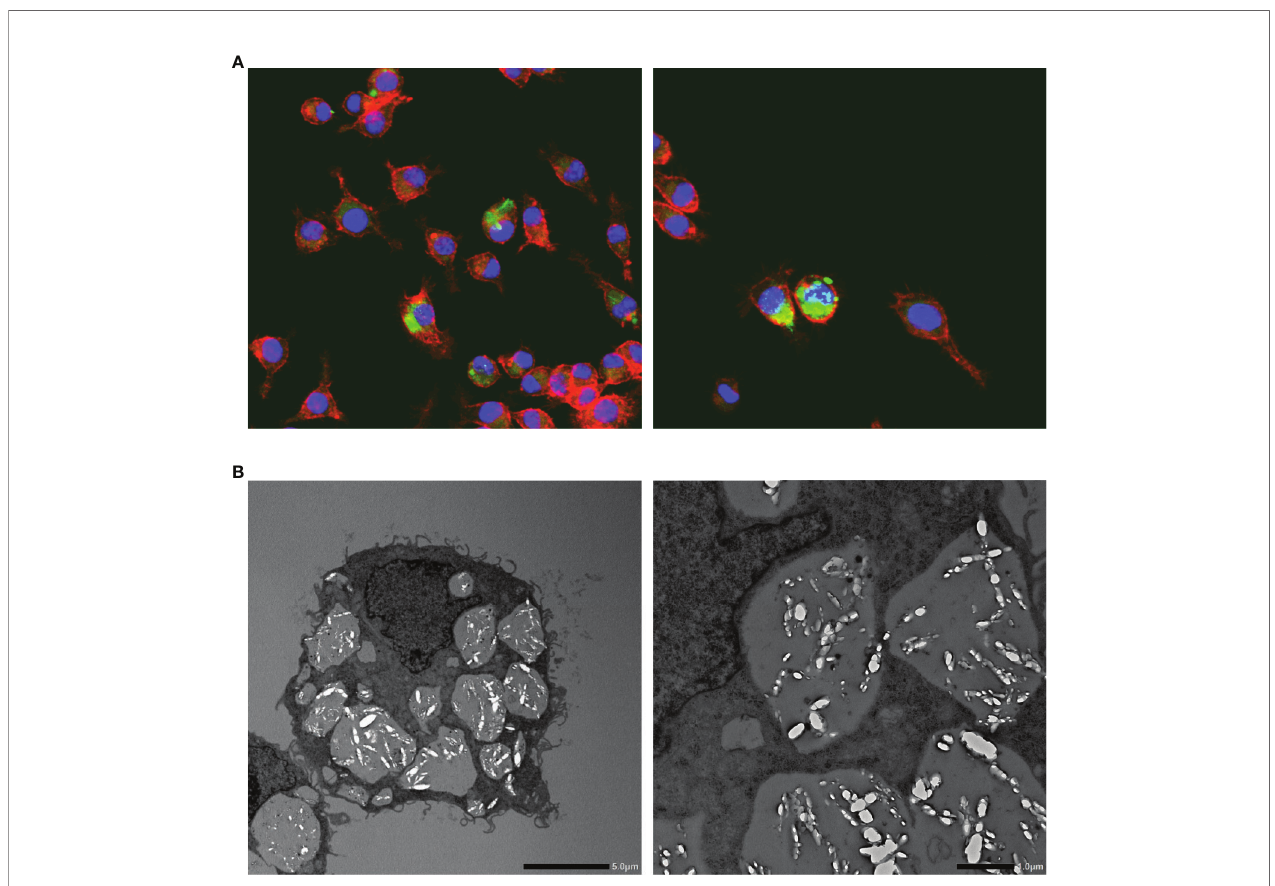
FIGURE 2 | Calcium oxalate crystal phagocytosis by macrophages. (A) Representative photographs show fl uorescent immunohistochemical staining of macrophages (RAW264.8) cultured with calcium oxalate monohydrate crystals. Red, phalloidin; Green: calcium oxalate monohydrate crystals; Blue, nucleus. Magni fi cation: ×400. (B) Transmission electron microscopy images of macrophages (RAW264.8) engul fi ng calcium oxalate monohydrate crystals. Scale bars, left and right panels, 5 and 10 m m,